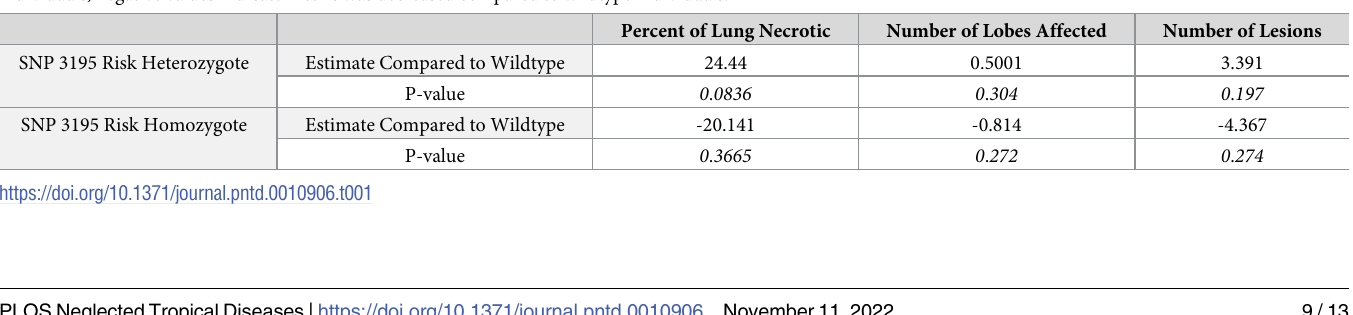
Table 1. Generalized linear models comparing the percentage of lung with necrotic lesions, number of lobes affected, and number of lesions within the lungs of the SNP 3195 homozygote (n = 4), heterozygotes (n = 12) and wildtype individuals (n = 20). Positive values indicate metric was increased when compared to the wildtype individuals, negative values indicate metric was decreased compared to wildtype